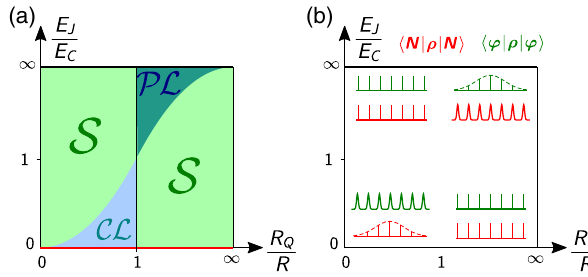
FIG. 4. (a) Reinterpreted Schmid-Bulgadaev phase diagram, in which the junction is superconducting everywhere, except for ¼ 0 . In the S parts, the junction is superconducting with a E J fully delocalized charge and, correspondingly, a fluctuationless (classical) compact phase. Partial charge (phase) localization occurs in the CL ( PL ) part. The classical phases S are artifacts which disappear when improving the model (see text and Appendix G). (b) Final description of the junction ’ s behavior in the parameter space. Drawings are sketches of the diagonal elements of the junction ’ s reduced density matrix in an extended description (red, charge representation; green, phase representa- tion). Close to the left (right) half of the upper (lower) axis, they nearly take the form of Dirac combs where the phase is almost a classical variable. In the lower left (upper right) sector, partial charge (phase) localization occurs, as in (a). The density matrix evolves continuously, interpolating between these limits, without any phase